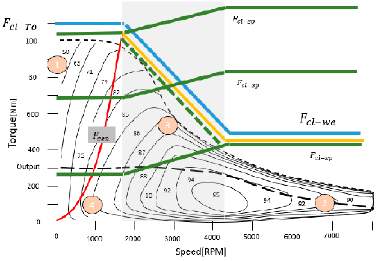
Appl. Sci. 2020 , 10 , x FOR PEER REVIEW Figure 14. Force graph including the speed ratio change and the sensing torque cam effect.